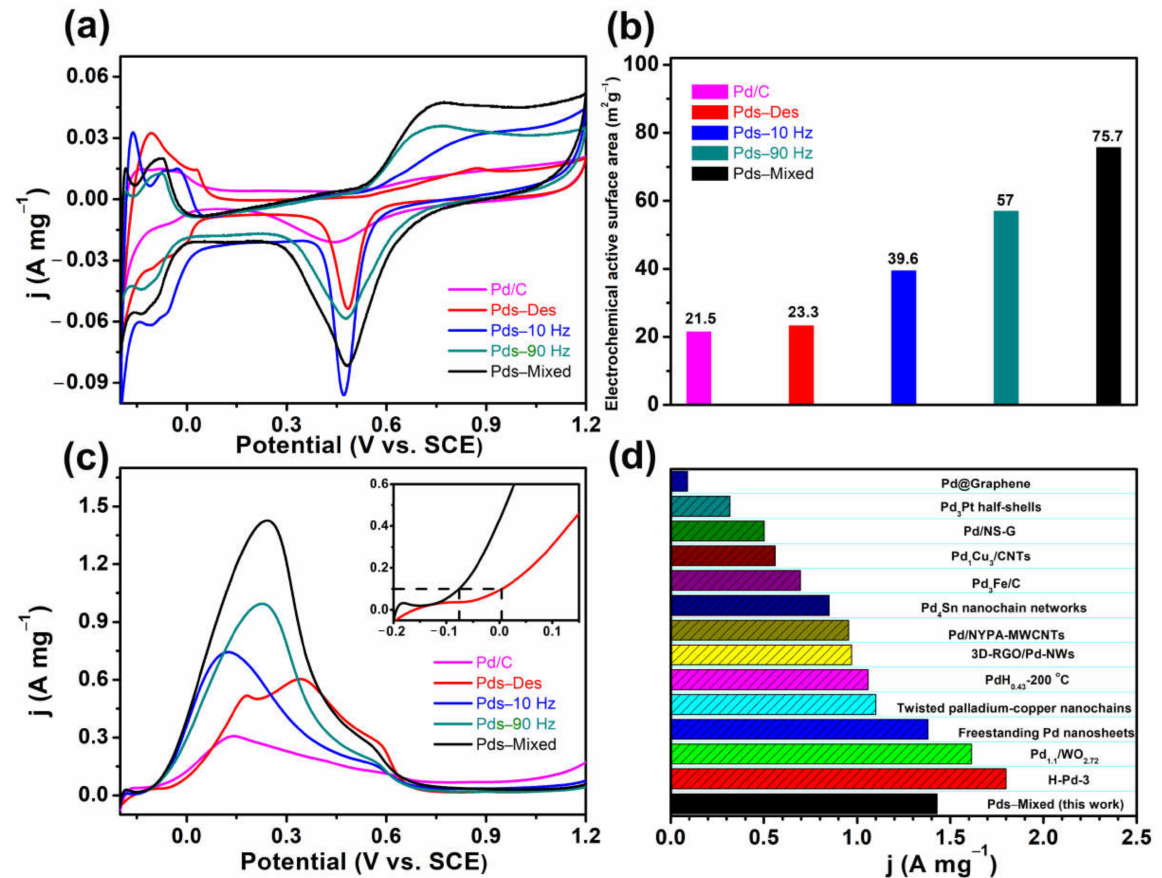
Figure 6. ( a ) Cyclic voltammograms of Pd/C, Pds–Des, Pds–10 Hz, Pds–90 Hz, Pds–Mixed in N 2 -saturated 0.5 M H 2 SO 4 solution at a scan rate of 50 mV s − 1 . ( b ) Calculated ECSA values based on the cyclic voltammograms (CV) curves in ( a ). ( c ) Mass activity of Pd/C, Pds–Des, Pds–10 Hz, Pds–90 Hz, Pds–Mixed in 0.5 M HCOOH + 0.5 M H 2 SO 4 solution at a scan rate of 50 mV s − 1 . ( d ) Comparison between Pds–Mixed and state-of-the-art Pd-based electrocatalysts in terms of catalytic current toward formic acid oxidation